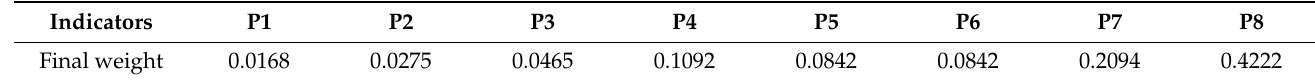
Table 4. Final weight of indicator layer (P).